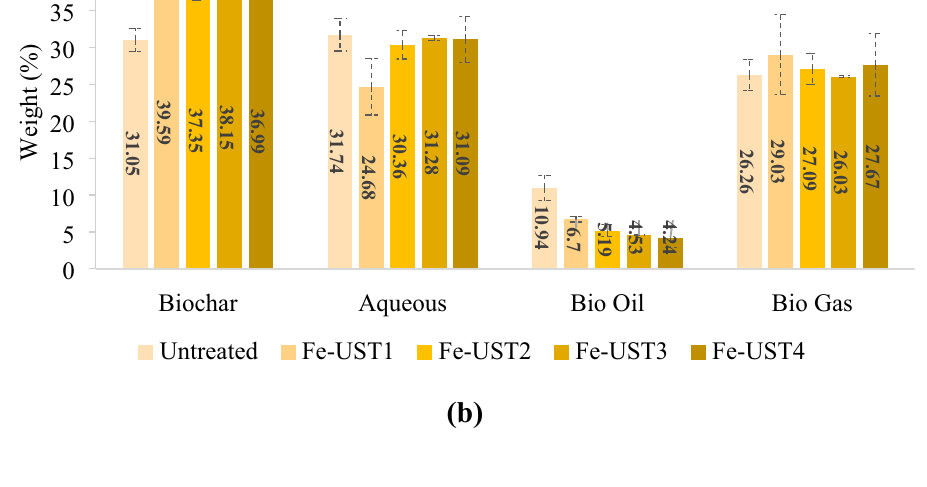
Table 2 Atomic percent of different elements present on biochar